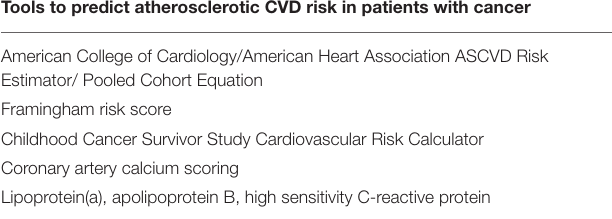
TABLE 3 | List of the risk stratification tools currently available to identify patients with cancer who are at increased risk of developing late atherosclerotic CVD. Tools to predict atherosclerotic CVD risk in patients with cancer American College of Cardiology/American Heart Association ASCVD Risk Estimator/ Pooled Cohort